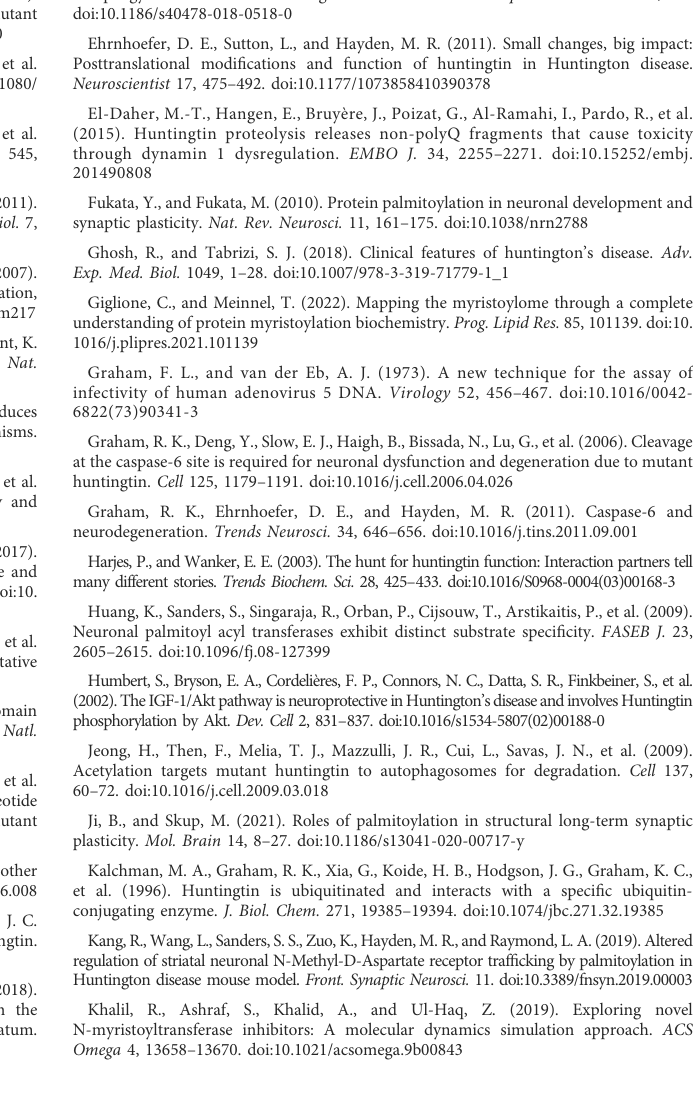
SUPPLEMENTARY FIGURE S4 Uncropped blots used for Figure 2F displaying total (MAB2166/green channel) and palmitoylated HTT (Streptavidin/red channel) measured by bio- orthogonal labeling assay in COS-7 cells transiently expressing 15Q-HTT1- 548 WT, C214S or C105/214/433S. SUPPLEMENTARY FIGURE S5 Uncropped blots used for Figure 3A and 3C displaying total (MAB2166/green channel) and palmitoylated HTT (Streptavidin/red channel) measured by IP- ABE or bio-orthogonal labeling assays in COS-7 cells transiently expressing 15Q-HTT1-1212 WT or C1027/1028S. SUPPLEMENTARY FIGURE S6 Uncropped blots used for Figure 3E displaying total (D7F7/green channel) and palmitoylated HTT (Streptavidin/red channel) measured by bio-orthogonal labeling assay in HeLa cells transiently expressing 15Q-HTT1-3144 WT, C214S, C3134S or C3144S. SUPPLEMENTARY FIGURE S7 Uncropped blots used for Figure 4B displaying total (D7F7/green channel) and myristoylated HTT (Streptavidin/red channel) measured by bio-orthogonal